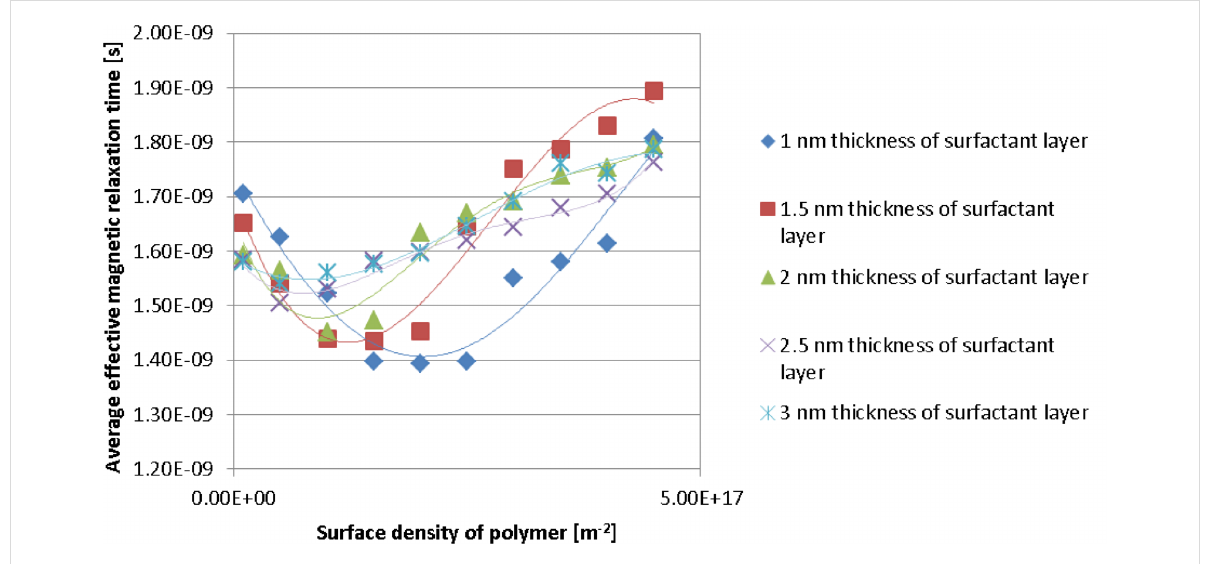
Figure 5: Average values of the effective magnetic relaxation time versus polymer surface density at different thickness values of the nanoparticle coating layer.